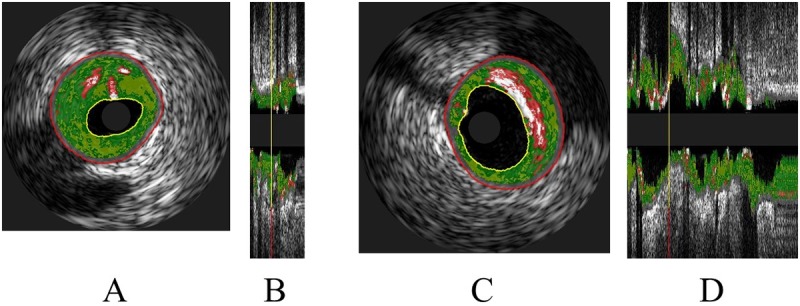
Representative virtual-histology intravascular ultrasound images.A. A cross-sectional image of the lesion in a patient in the low apolipoprotein B (LAB) group. The composition of the entire lesion by volume percentage is fibrous (green), 54.43%; fibrofatty (light green), 29.09%; necrotic core (red), 12.96%; and dense calcium (white), 3.52% B. Longitudinal section of the lesion in the same patient in the LAB group. The yellow line indicates the location of the cross-section shown in (A). C. A cross-sectional image of the lesion in a patient in the high apolipoprotein B (HAB) group. The composition of the entire lesion by volume percentages are as follows: fibrous (green), 48.99%; fibrofatty (light green), 20.24%; necrotic core (red), 22.36%; and dense calcium (white), 8.41%. D. Longitudinal section of the lesion in the same patient in the HAB group. The yellow line indicates the location of the cross-section shown in (C).